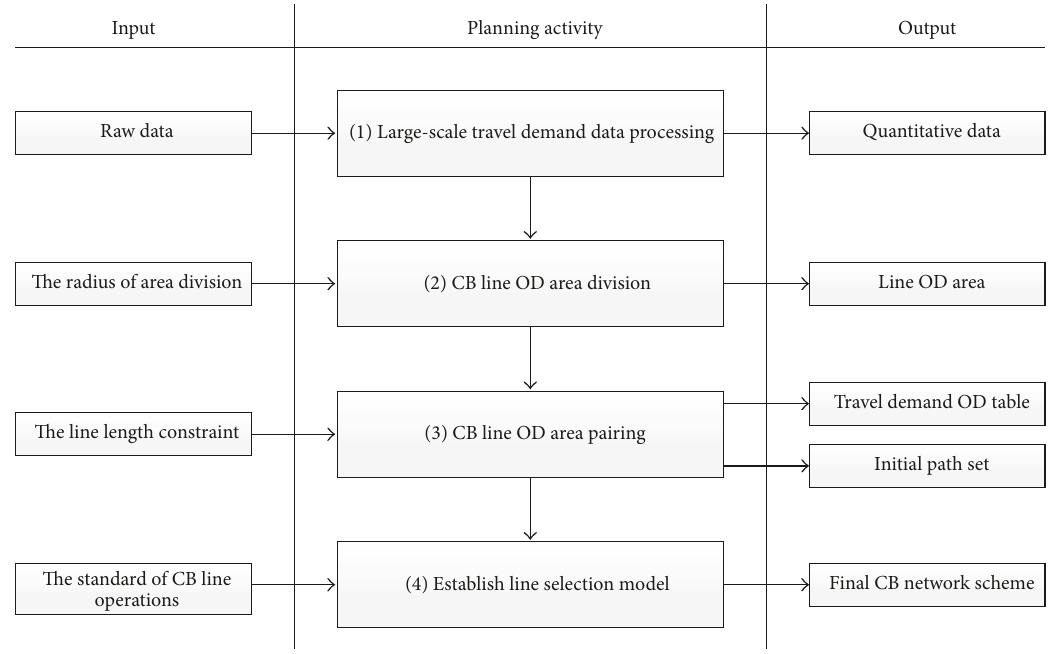
Figure 1: CB network planning